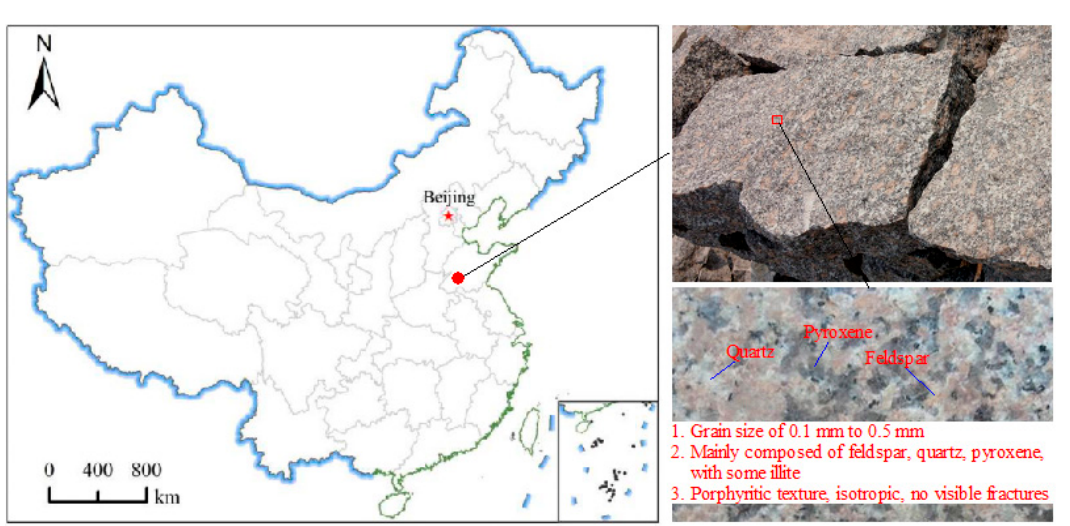
Figure 1. Collection location and basic form of the granite blocks.